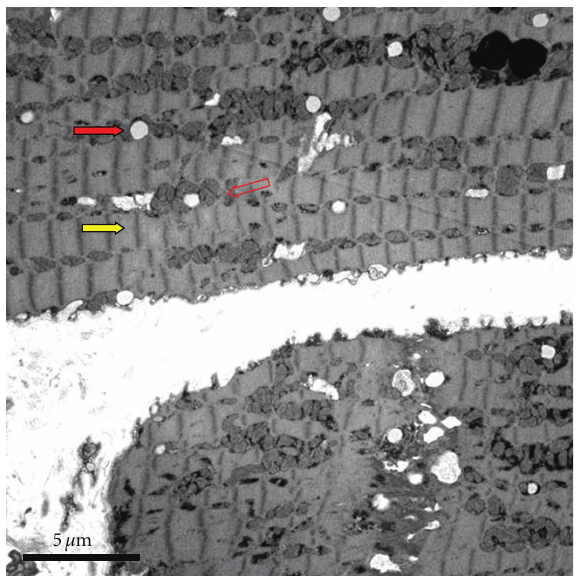
Figure 1: Transmission electron micrographs of endomyocardial biopsy from patient with systolic heart failure treated with a TKI. Section shows hypertrophy and interstitial edema with edematous mitochondria (open red arrow), with increased lipid droplets (solid red arrow) and dilatation of sarcotubular elements (yellow arrow). These findings are consistent with acute but reversible